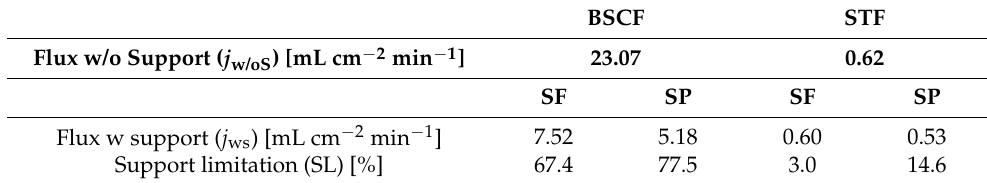
Table 4. Flux with and without support for BSCF and STF; limiting effect of the support.